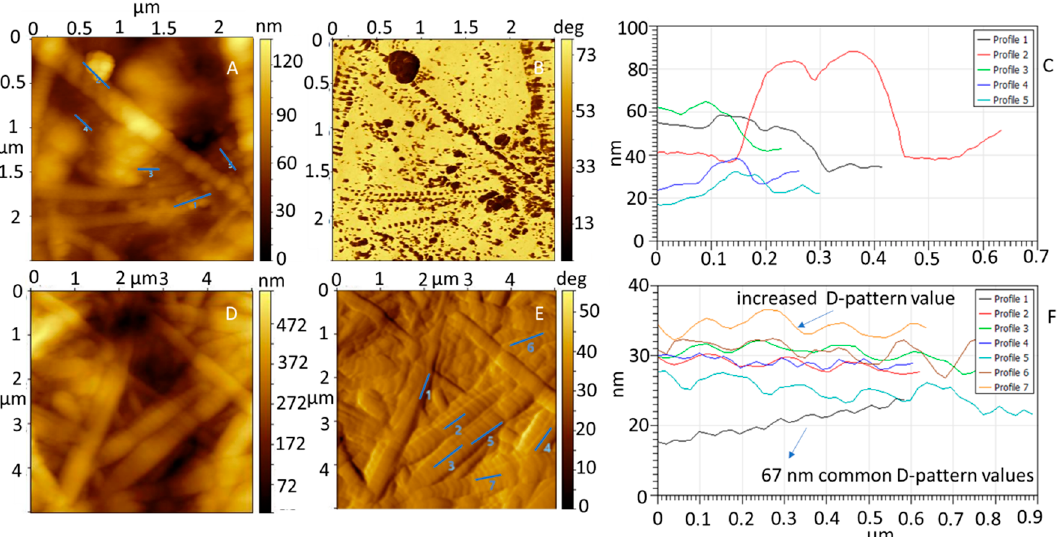
Figure 4. ( A ) AFM topography and ( B ) phase image of collagen impregnated with propolis NPs. ( C ) Cross-section of the line profiles shown in ( A ). ( D ) AFM topography image of collagen impregnated with propolis NPs. ( E ) Amplitude image of the topography image shown in ( D ). ( F ) Cross-section of the line profiles shown in ( E ). The collagen D-pattern gap was increased.